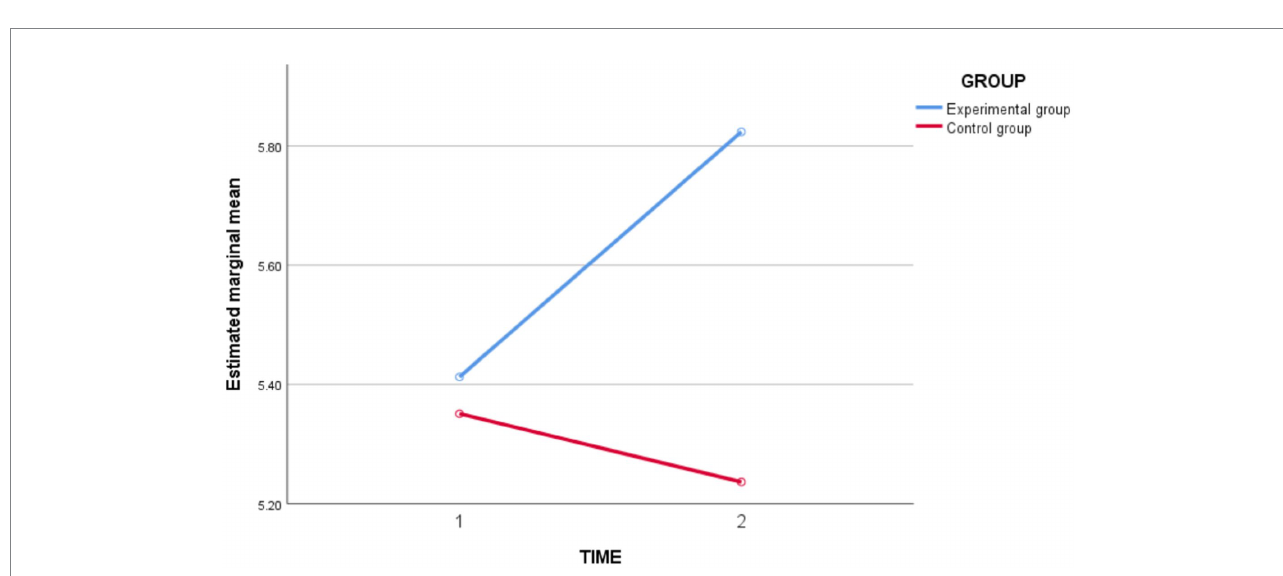
FIGURE 3 Schematic diagram of changes in study engagement on the experimental group and the control group before and after the